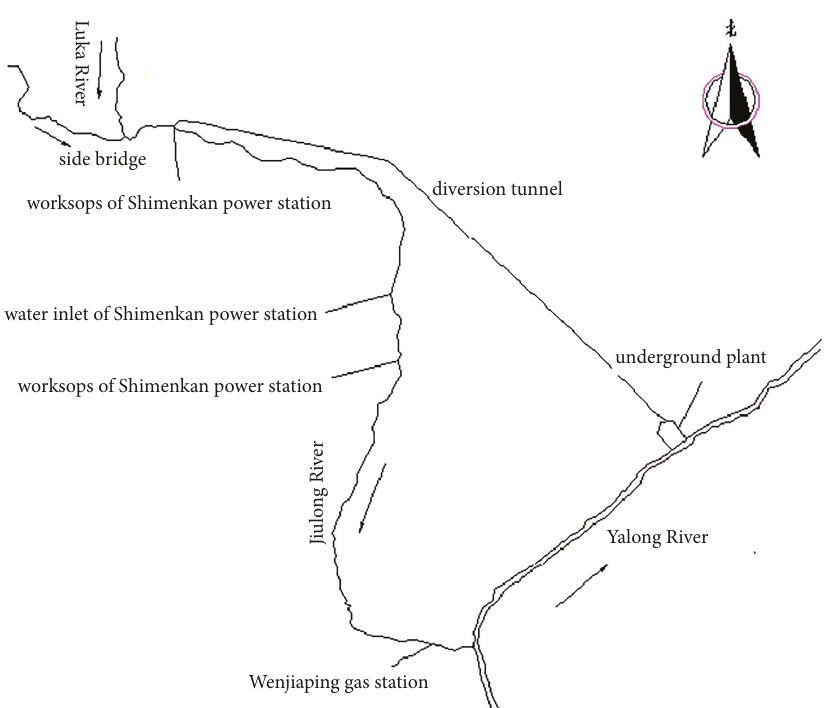
Figure 2: The geographical location of the diversion tunnel